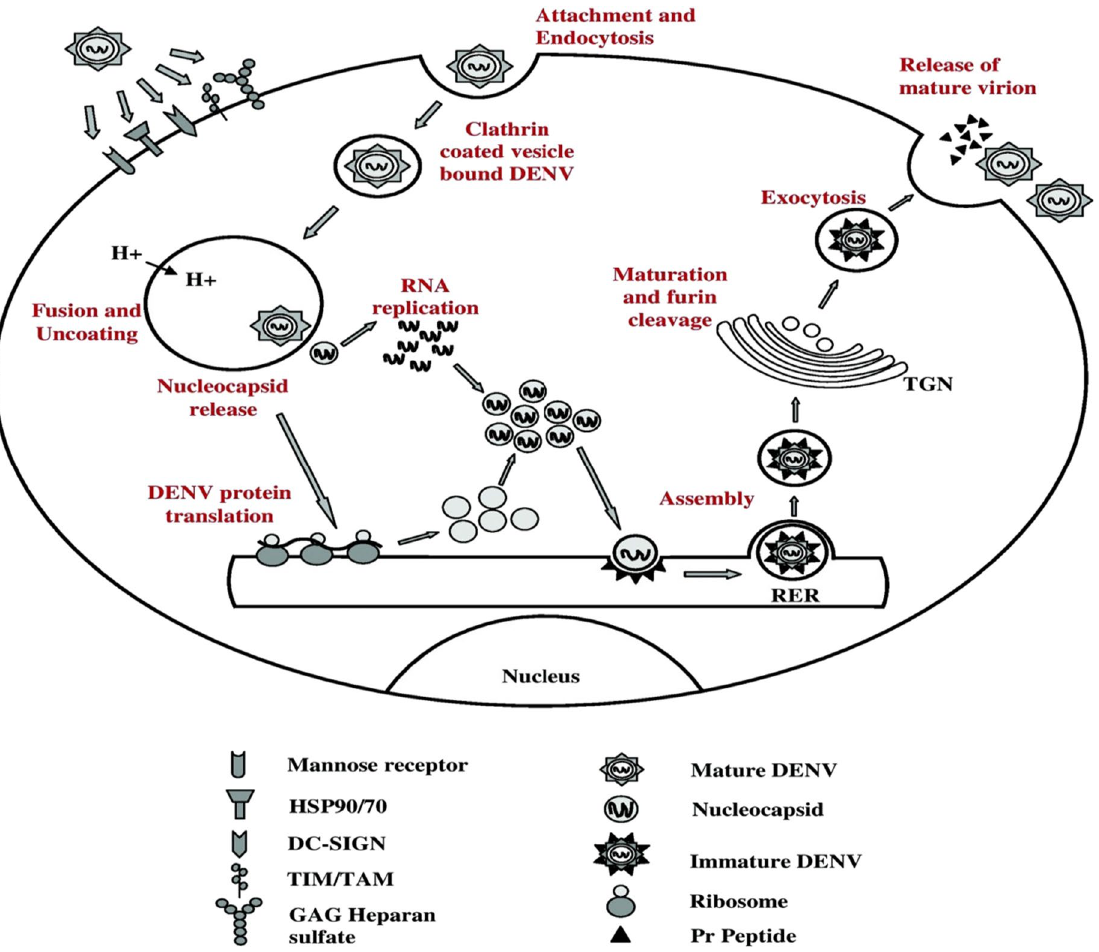
Fig. 3 Step-by-step processes of dengue virus entry in the host cell and its life